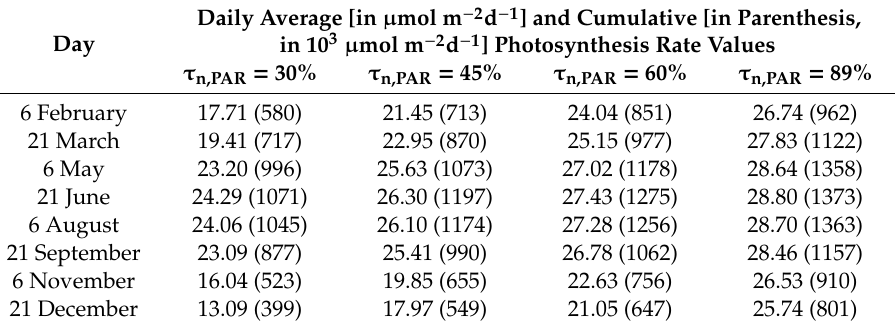
Table 10. Daily photosynthesis rate at plant level.